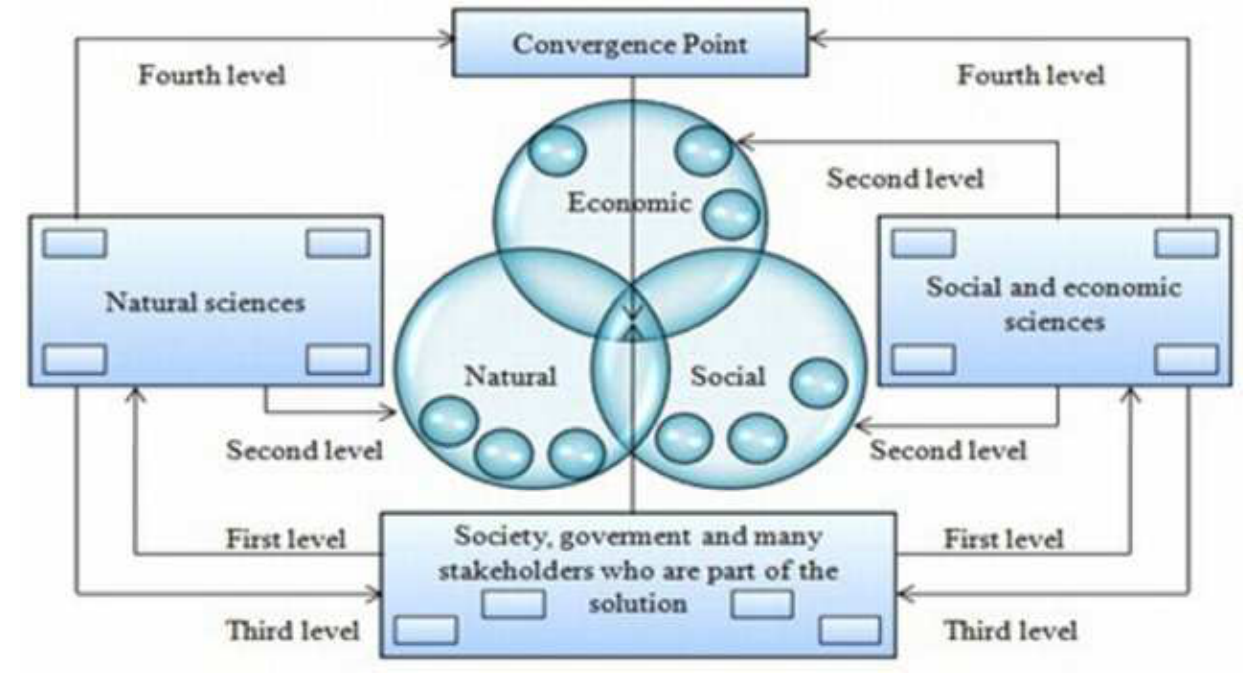
Fig. 3. Diagram showing the dynamics among all participants when elaborating an ecosystem management plan. The first phase of MEZA program (first two semesters).